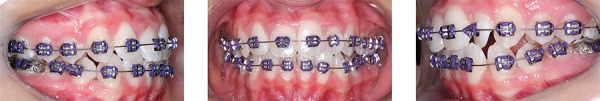
Intraoral photographs 12 months after treatment onset.